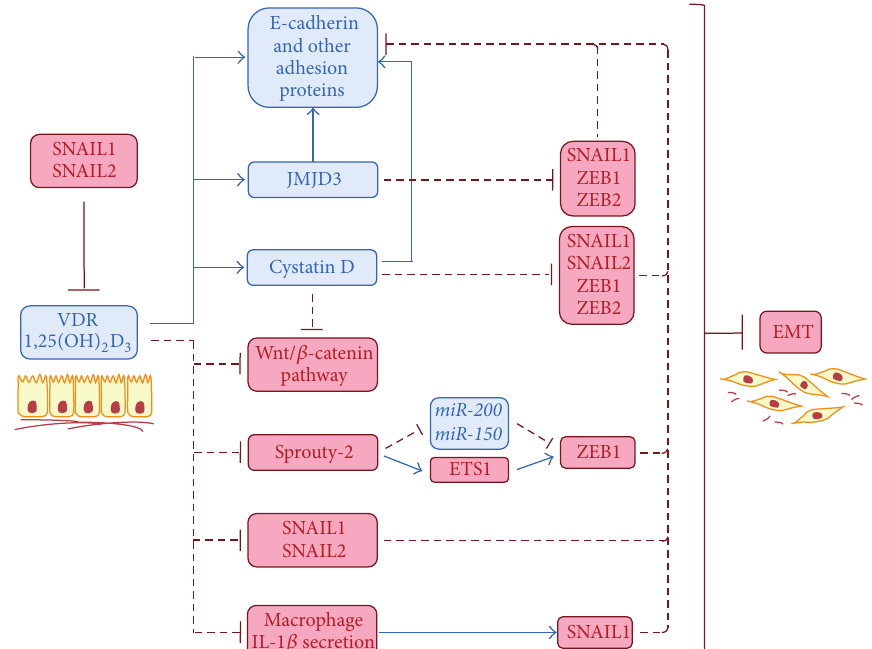
Figure 1: Scheme showing the mechanisms involved in the reciprocal regulation between 1,25(OH) 2 D 3 and EMT in human colon cancer cells. Proteins and pathways displayed in blue are associated with an epithelial phenotype, while those shown in red are related with a mesenchymal phenotype. Blue and red lines are used to indicate induction or repression,